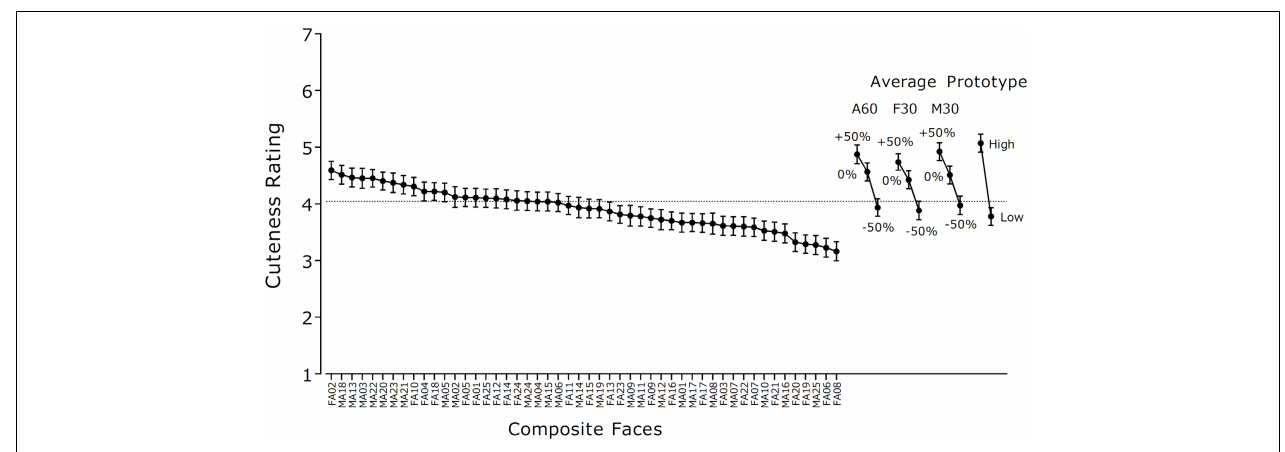
FIGURE 2 | Mean cuteness rating scores for 50 composite faces, average faces (0%), manipulated faces (+50%, –50%), and prototypical high- and low-cuteness faces ( N = 229). 1 = not cute (kawaii) at all , 7 = extremely cute (kawaii). Error bars indicate 95% confidence intervals. A60: Average face of 30 female and 30 male babies. F30: Average face of 30 female babies. M30: Average face of 30 male